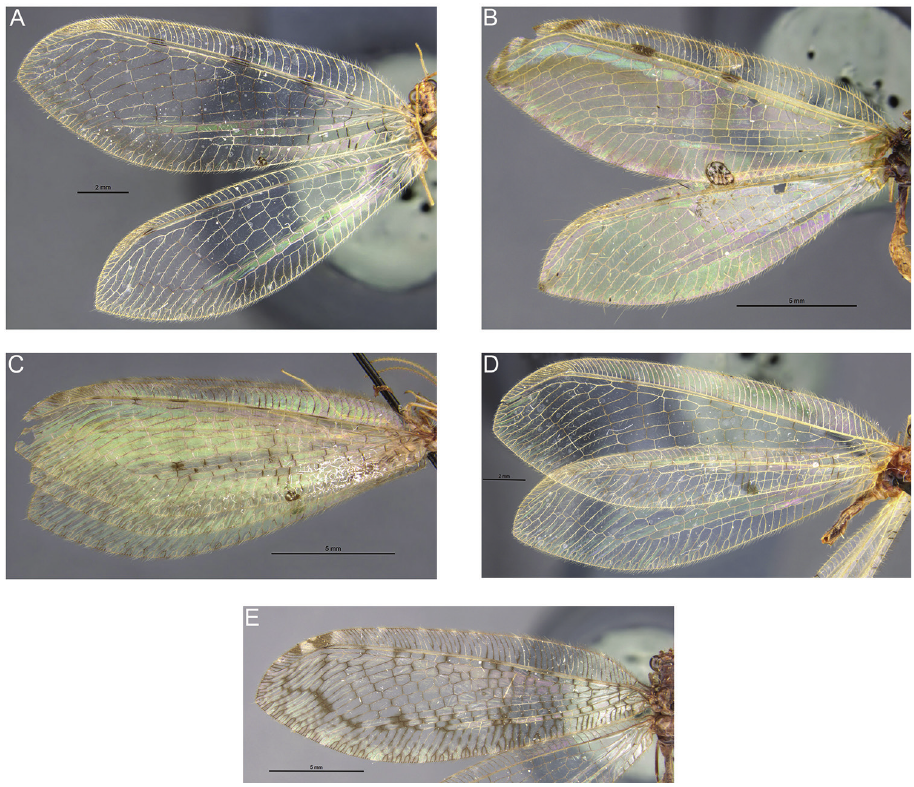
Figure 6. Detail of wings of the holotypes of Spilosmylus species described by Nathan Banks from the Philippines. Photographs by Philip D. Perkins, Museum of Comparative Zoology, Harvard University; original photography © President and Fellows of Harvard College. A Spilosmylus alticolus Banks, 1937 B Spilosmylus formosus Banks, 1924 C Spilosmylus apoanus Banks, 1937 D Spilosmylus proximus Banks, 1937 E Spilosmylus monticolus (Banks, Key to the species of Spilosmylus known from the Philippines 1 Forewing with embossed spot (Fig. 2B) ...................................................... 2 – Forewing without embossed spot (Fig. 2A) ................................................. 8 2 Forewing radial and medial area with dark grey spots in the medial area (Fig. 2B) ................................................................ S. tephrodestigma sp. n. Forewing radial and medial area without such markings ............................. 3 3 Forewing with diffuse amber shadings (Fig. 6B) .......................................... 4 – Forewing without amber shadings............................................................... 5 4 Forewing veins Sc and R with 5 dark dashes, subcostal area unmarked ......... ......................................................................... S. inquinatus (McLachlan) – Forewing veins Sc and R with 2 dark dashes, subcostal area with two dis- tinct, large dark brown markings covering the dark dashes; embossed spot very large (Fig. 6B) ......................................................... S. formosus Banks